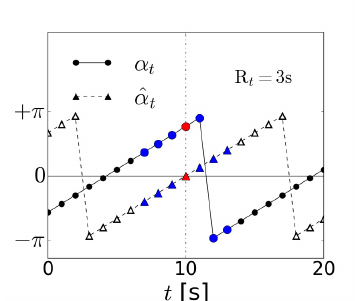
Figure 3. Angle of the PC before centering (circles) and after centering around t = t 0 = 10 s (triangles) for ∆ t = 1 s and R t = 3 s: Red denotes the point of interest, and blue indicates the neighbour points